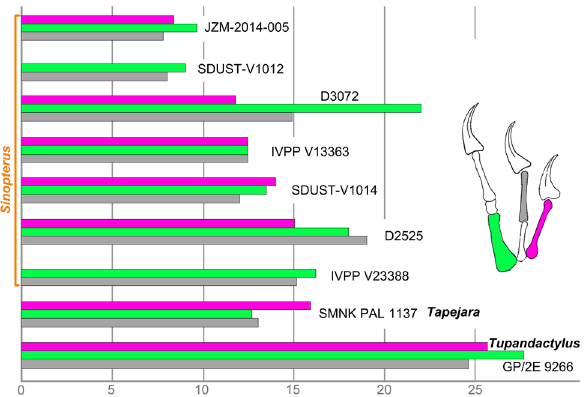
Figure 4. Comparisons of selected tapejarid manual phalanges. Phalangeal measurements are from this study and the literature 3,6,7,27,29,32,35,37 . Purple represents the manual phalanx I-1, green the manual phalanx III-1, and grey the manual phalanx II-2. Reconstruction of manual digits I–III is based on